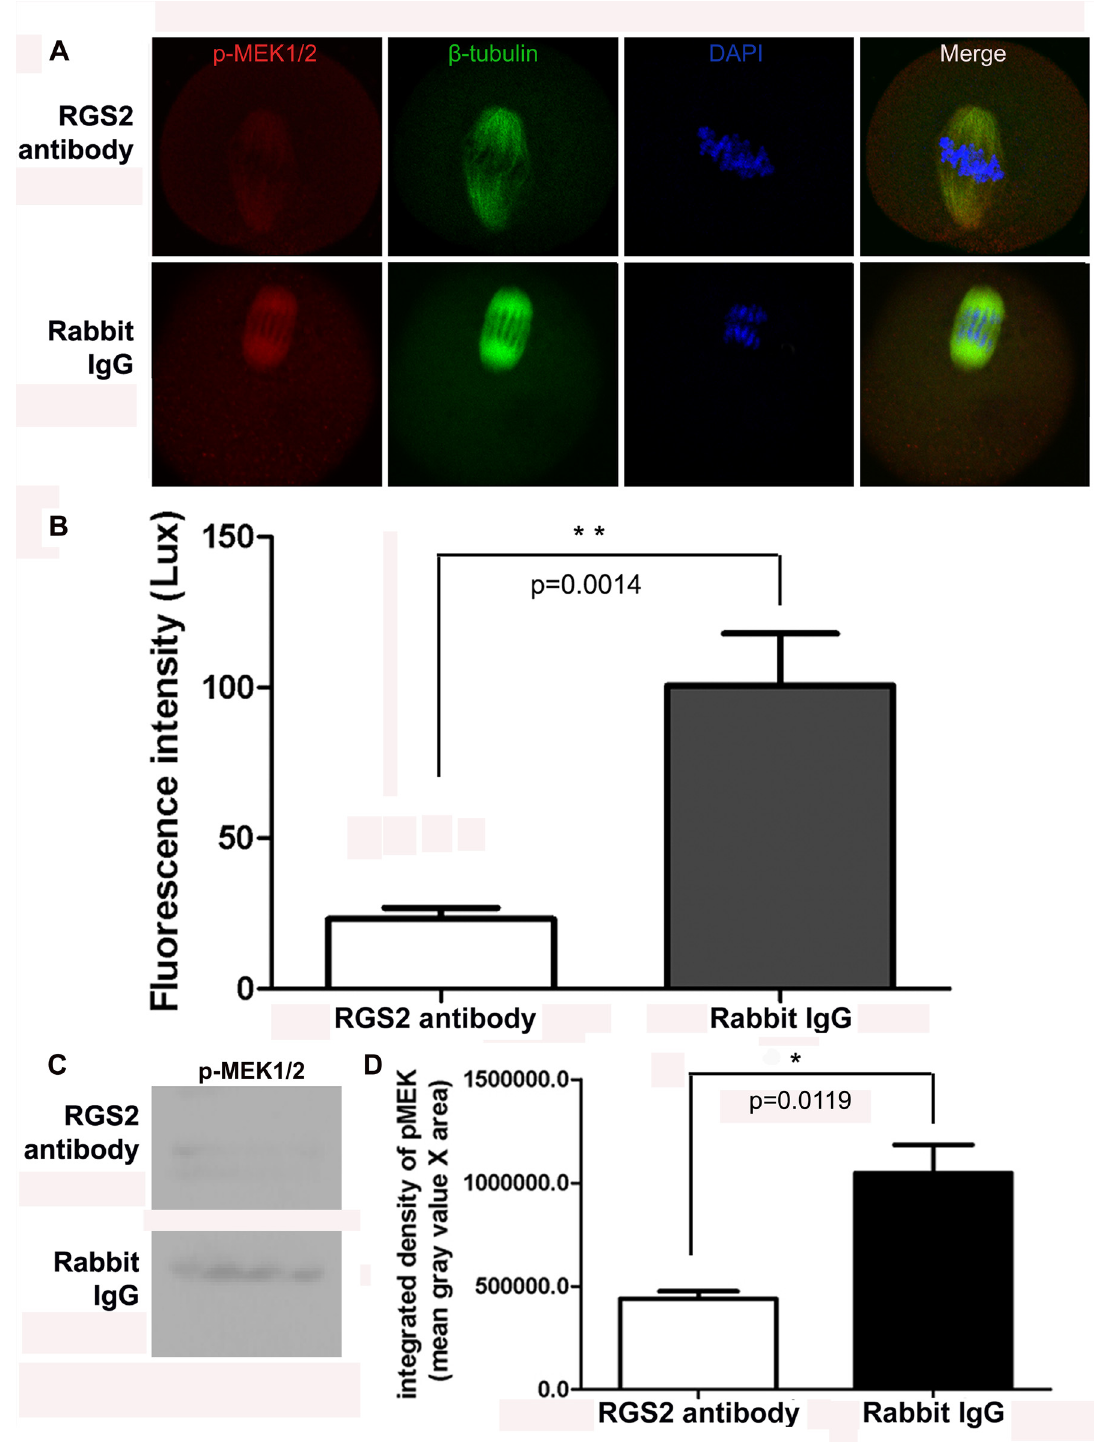
Fig 5. Antibody-mediated inhibition of the binding of RGS2 and β -tubulin reduced the expression of p-MEK1/2 in meiotic spindles during oocyte maturation. (A) p-MEK1/2 was localized in the microtubule-organizing center of spindles in rabbit IgG-injected oocytes. However, in anti-rgs2 antibody-injected oocytes, the p-MEK1/2 signal was very week or not visible. p-MEK1/2 was labeled with Alexa Fluor 594 (red), while β -tubulin was stained with FITC (green) and nuclei were stained by DAPI (blue). (B) Fluorescence intensities of p-MEK1/2 protein in control and anti-Rgs2 antibody-injected